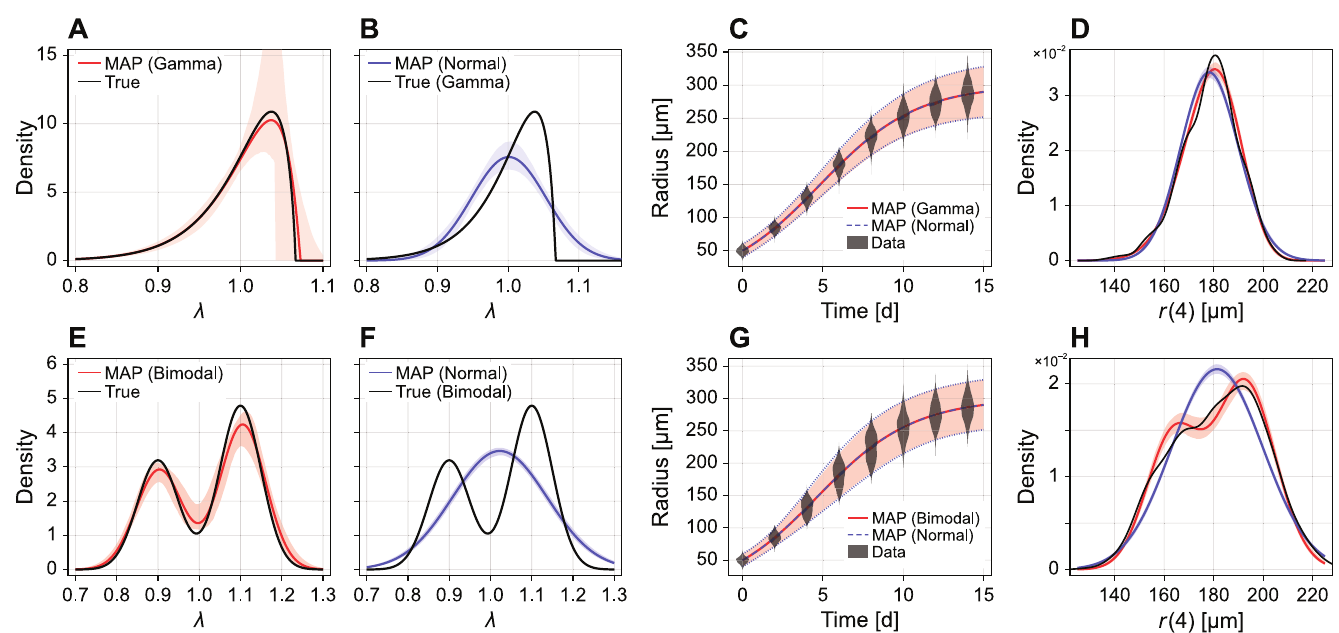
Fig 5. Inference and prediction where parameter distribution is misspecified. We explore a case where the underlying growth rate distribution has (A–C) a skewed distribution with ( μ λ , σ λ , ω λ ) = (1, 0.05, − 1.5), and (e–g) a bimodal distribution, modelled as the mixture w λ 1 + (1 − w ) λ 2 with l and w = 0.4. To ensure identifiability, we use a large sample size of N = 1000 per time point. In (A,E) the true form of the growth rate distribution is used, whereas in (B,F) the growth rate distribution is misspecified and assumed to be normal. Shaded regions in (A,B,E,F) indicate 95% credible intervals for the density. In (C,G), predictions at the MAP estimates (equivalent to MLE) are compared to the data. A 95% prediction interval is shown for the true model (shaded) and the misspecified model (blue dashed), solid curves to the mean, and violin plots show the data. In (D,H), we compare predictions for the density from the true and misspecified models at t = 4.